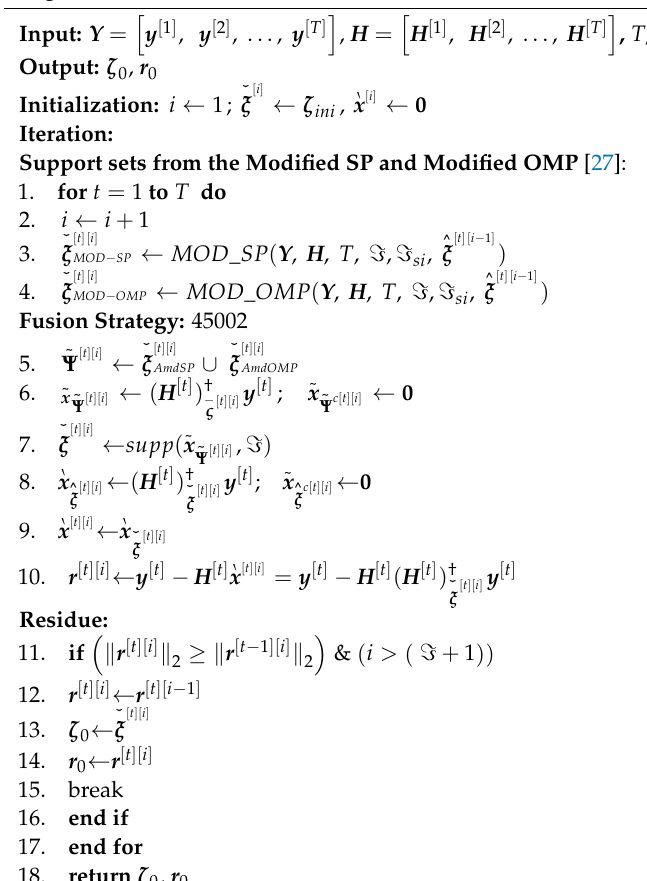
Algorithm 1 Fused Modified OMP-Modified